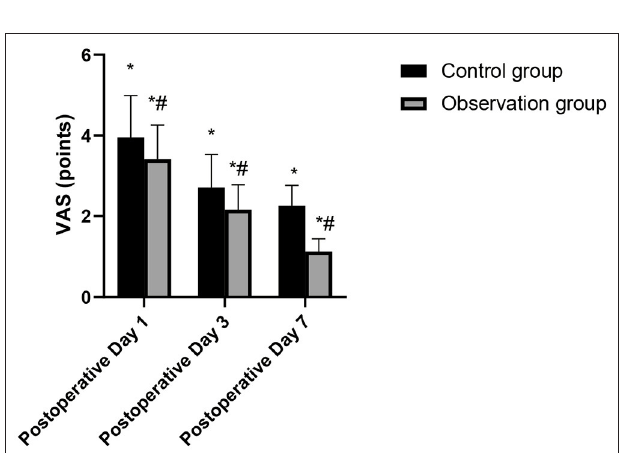
FIGURE 2 | Comparison of VAS scores in the patients of the two groups. Compared with postoperative, * p < 0.05. Compared with the control group, # p < 0.05.